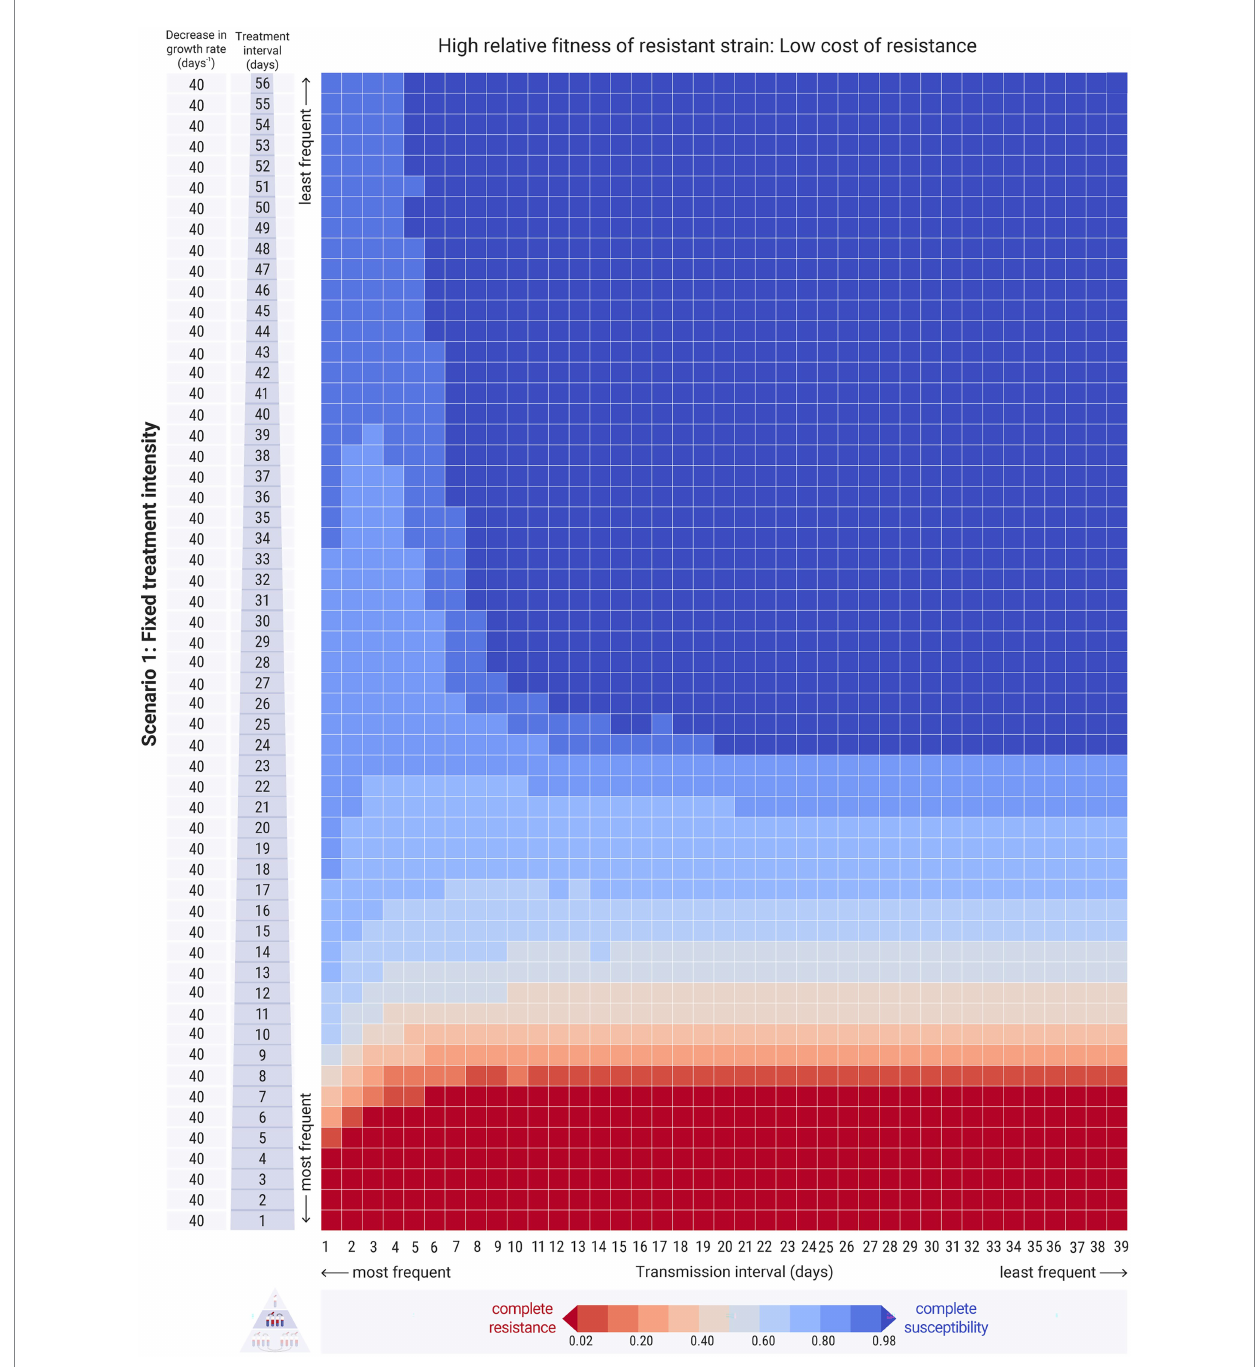
FIGURE 6 Results of the between-hosts simulations across different treatment intervals ( I antim , y-axis) and transmission intervals ( I trans , x-axis). Each cell of the heatmap represents the equilibrium values of one experiment. The colour bar represents the average equilibrium ratio of susceptible bacteria in the host population. Scenario 1, where the decrease in the intrinsic growth rate due to the antimicrobial treatment is fixed across experiments at 40 d Smax = day − 1 . The relative fitness of the resistant is set to strain a higher level, at 0.9 w = , indicating a low cost of resistance. For the results on 0.9 w > refer to Supplementary Figures